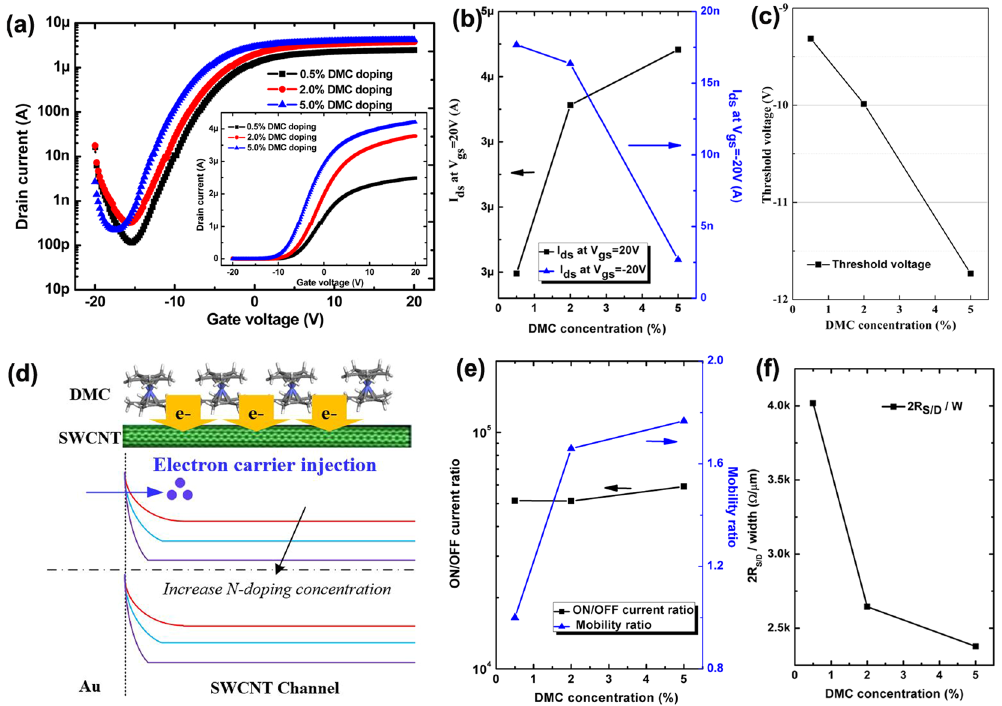
Figure 3. ( a ) The transfer curves ( I ds - V gs ) of the a CNFET device on a logarithmic scale after spin-coating DMC/DMF solutions with different concentrations ranging from 0.5 to 5.0 wt.% at V ds = 5 V. Inset shows the transfer curves on a linear scale. ( b ) The drain current value ( I ds ) at V gs = 20 V and − 20 V as a function of DMC concentration. ( c ) Threshold voltage value of the doped CNFET device as a function of DMC concentration. ( d ) The schematic energy band diagrams of the Au-SWCNT heterojunction exhibiting the electron barrier height and region width reduced by increasing DMC concentrations. ( e ) The ON/OFF current ratio ( I on / I off ) at V ds = 5 V and the field-effect electron mobility ratio ( μ FE ratio = μ FE − DMC / μ FE-DMC = 0 . 5wt .% ) as a function of DMC concentrations. ( f ) Contact resistance extracted by using the gated transmission line method as a function of DMC